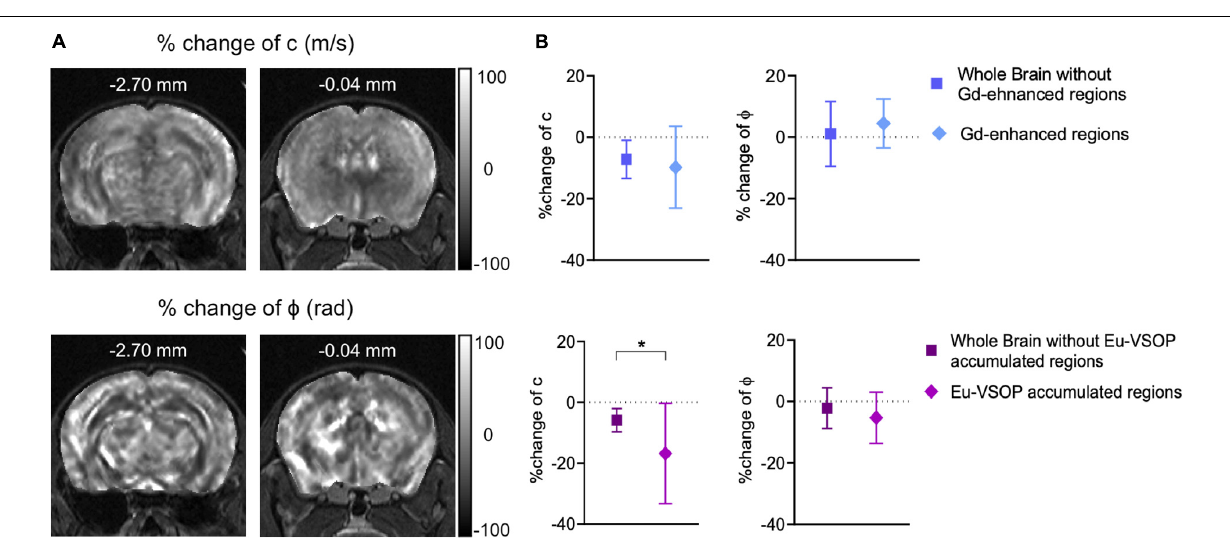
FIGURE 7 | MRE is sensitive to stiffness changes in sites of Eu-VSOP accumulation. (A) Representative percentage change maps of c- and φ -map. (B) Percentage change in areas with Gd enhancement (within cerebral cortex, cerebral nuclei, brain stem, midbrain and fiber tracts) compared to non-enhancing areas revealed no significant difference (top), for c in m/s p = 0.3321 (Wilcoxon matched-pairs rank sum test), for φ in rad p = 0.1246 (paired t -test), n = 19; percentage change of region with Eu-VSOP accumulation (within cerebral cortex, cerebral nuclei, brain stem, midbrain and fiber tracts) (bottom) compared to non-hypointense areas showed a significant difference for c ( p = 0.0483, paired t -test, mean ± SD, n = 8, * < 0.05) whereas φ was not affected ( p = 0.2889, paired t -test, mean ± SD n = 8, * < 0.05). Percentage change maps are based on the percentage difference from peak to